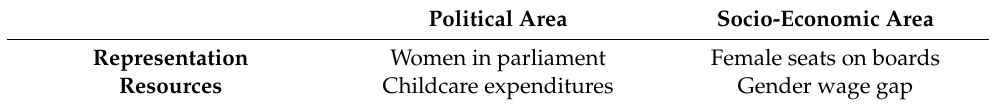
Table 1. Spheres of gender equality. Political Area Socio-Economic Area Representation Women in parliament Female seats on boards Resources Childcare expenditures Gender wage gap Source: own